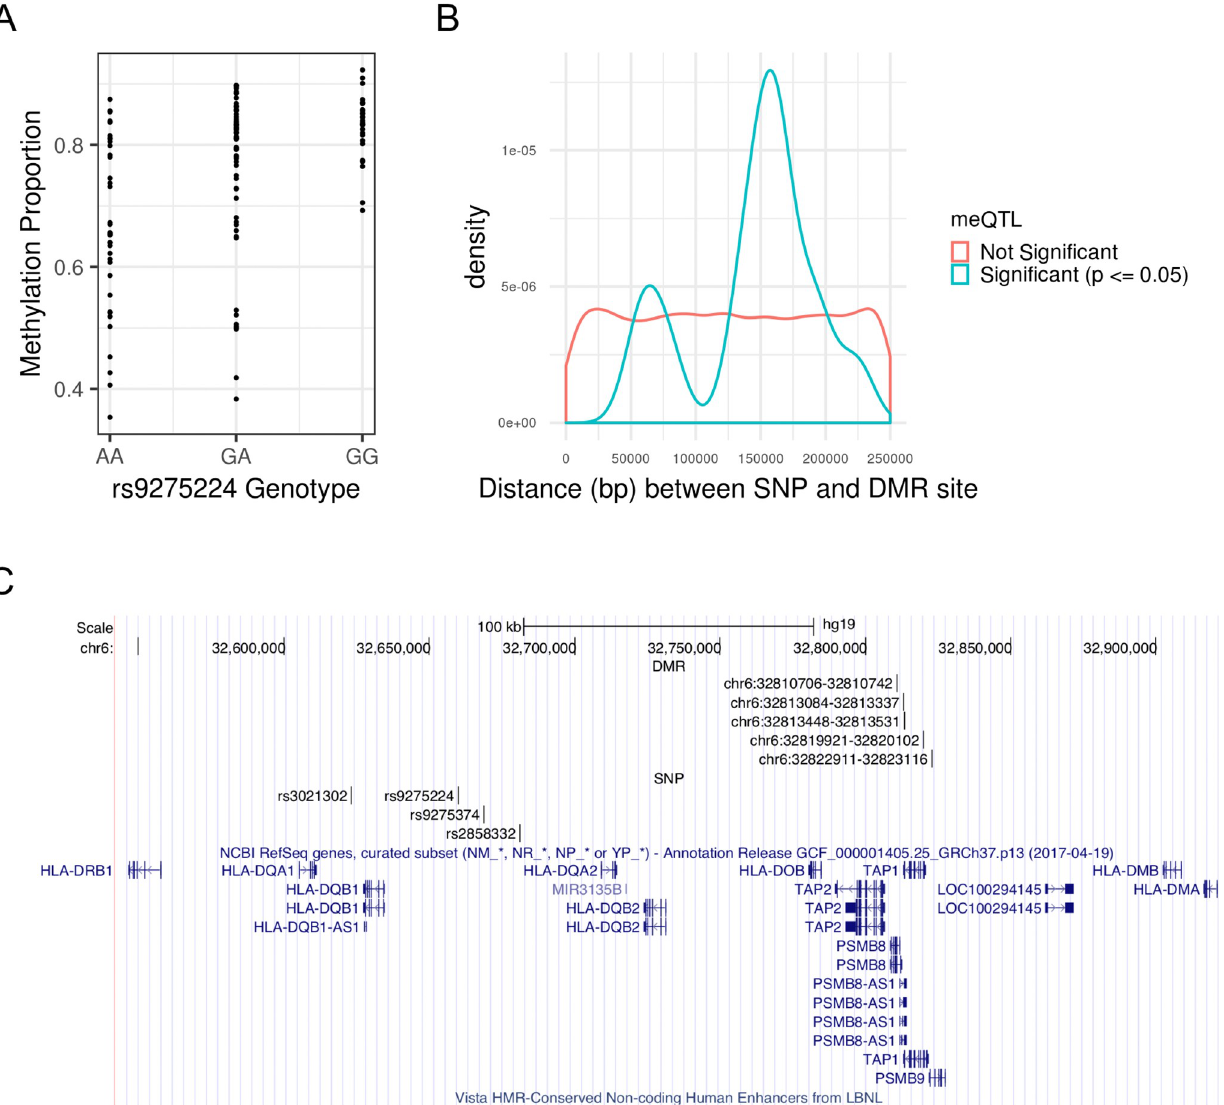
Fig 2. MeQTLs associated with SS DMR methylation M-values. (A) SNP rs9275224 is a meQTL associated with average M-value of the DMR at genetic positions 32,810,706–32,810,742 (GRCh37) on chromosome 6. See S3 Table for the remaining meQTL-DMR pairs. (B) Density plot of associated and unassociated SNP-DMR pairs by absolute distance. The significance criteria for association is having a Benjamini-Hochberg adjusted p-value (p) � 0.05. While distance is approximately uniformly distributed for unassociated SNP-DMR pairs, the distances of associated SNP-DMR pairs is concentrated around 153 kb. (C) MHC region spanning the HLA-DQA1 , HLA-DQB1 , and HLA-DQA2 loci with high density of the meQTL-DMR pairs. Each DMR is specified by its chromosome, starting position, and ending position, in GRCh37 genetic coordinates.